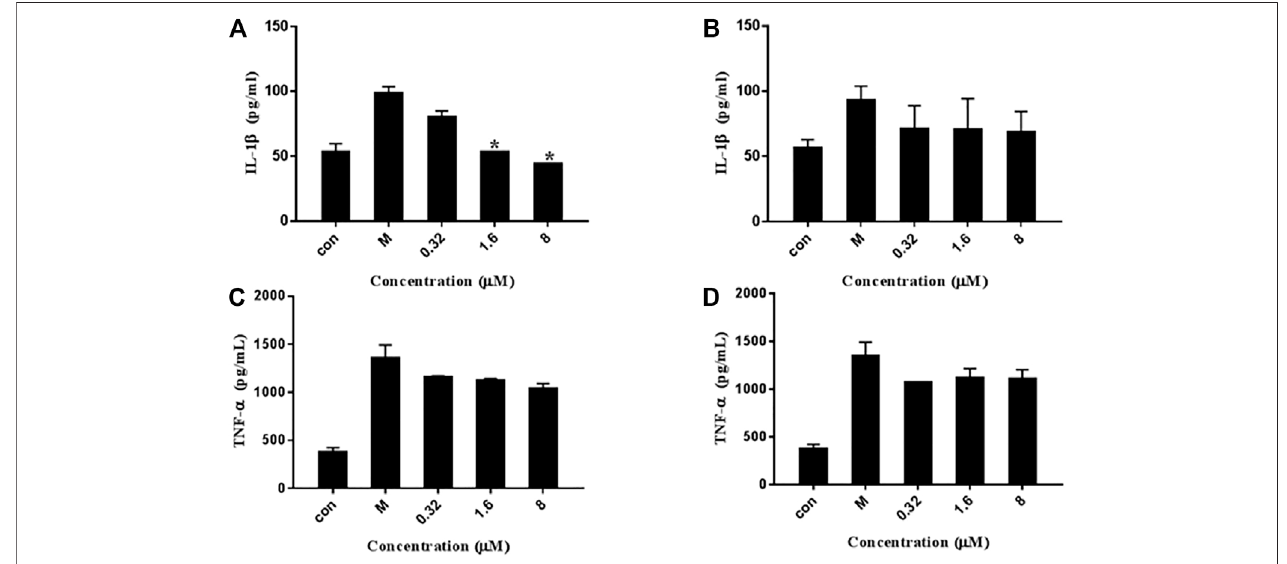
FIGURE8| Effectsof7979989andZ112553128onTNF- α andIL-1 β inducedbyLPS.Inadditiontoanuntreatedcontrolsample,RAW264.7cellswerepretreated withdifferentconcentrationsof7979989andZ112553128(8,1.6,and0.32 µM)for1.5 handthentreatedwith1 µg/mlLPSat37 ° Cfor24 htheculturesupernatantsof RAW264.7 macrophages were then detected by ELISA. (A) The levels of IL-1 β inhibited by 7979989, (B) The levels of IL-1 β inhibited by Z112553128, (C) TNF- α suppressed by 7979989, (D) The levels of TNF- α inhibited by Z112553128. Each bar represents the mean ± standard deviation (SD) calculated from three independent experiments. * p < 0.05 compared with M group (only LPS-treated group).